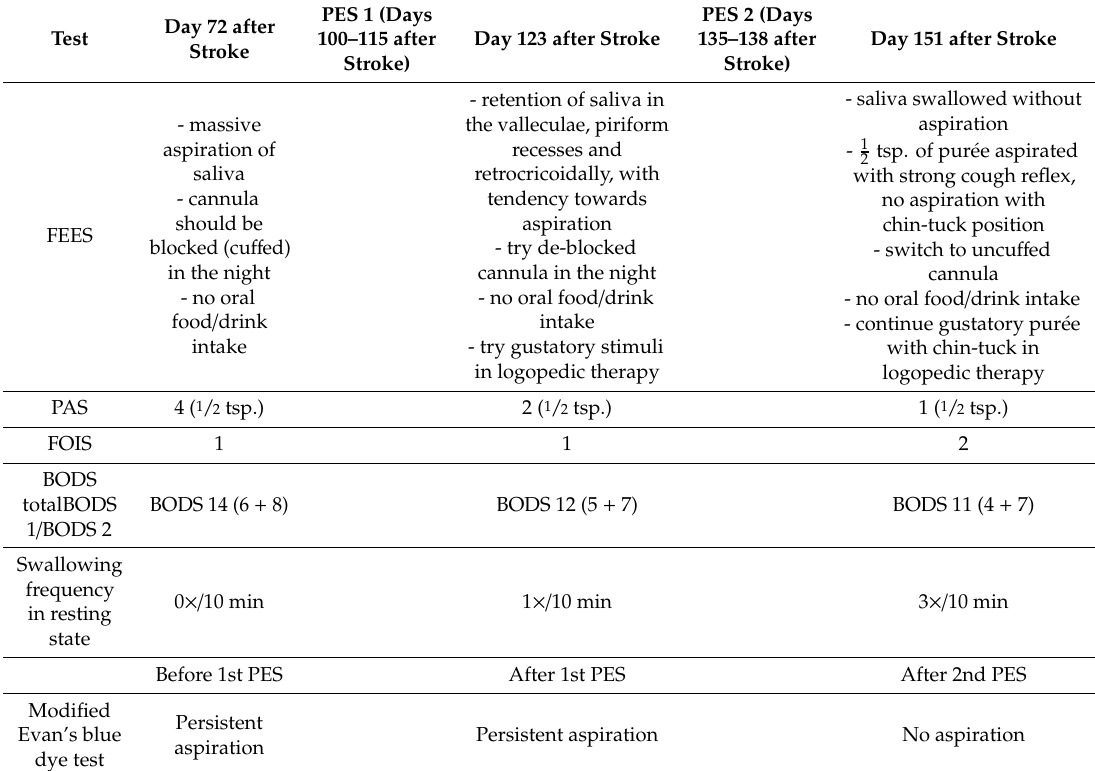
Table 1. Chronological presentation of the results from evaluation tests and scores before and after pharyngeal electrical stimulation